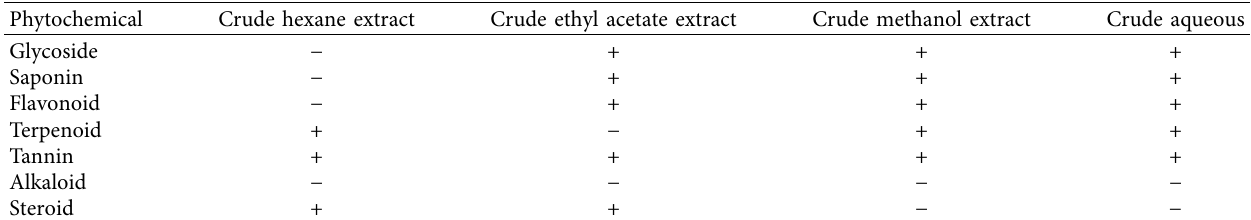
Table 1: Phytochemical screening of the various crude extracts from Salvia serotina L. (chicken weed). Phytochemical